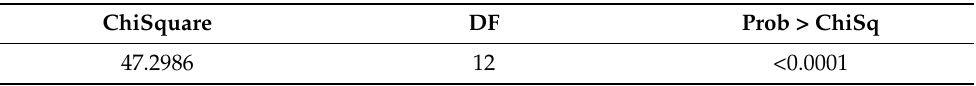
Table 6. Result of Kruskal–Wallis tests—analysis of variability CO 2 with the influence of the depth.